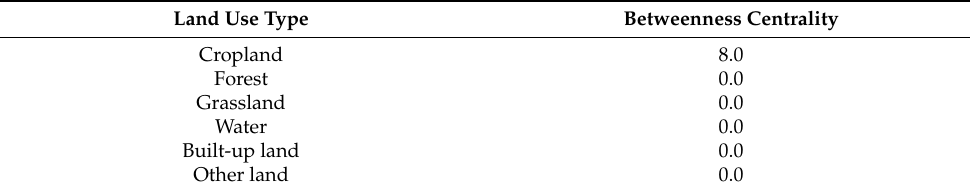
Table 9. Betweenness Centrality of the land use change from 1990–2000.